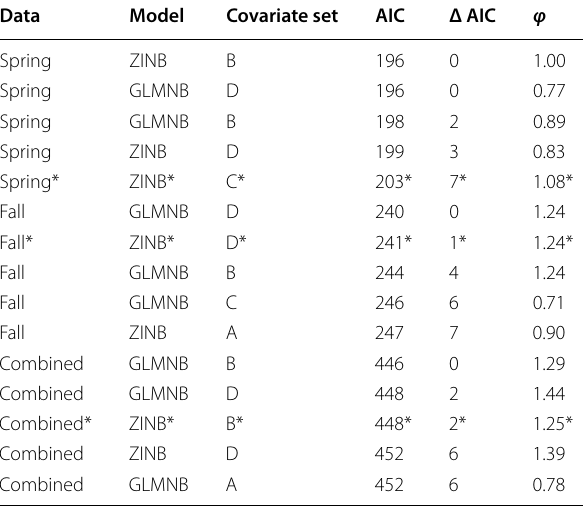
Table 2 Results of the top five best-fit models for spring, fall, and combined data. A breakdown of covariate set configurations can be found in Table 1